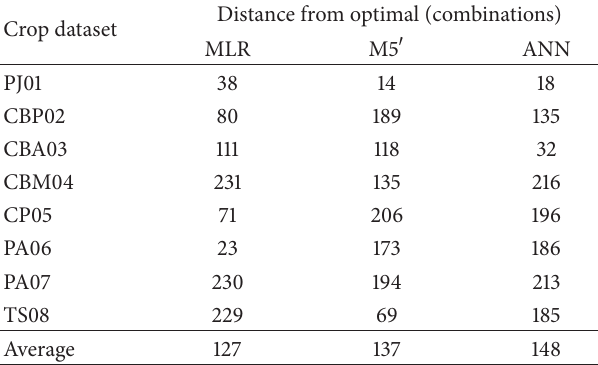
Table 7: Distance from OAS error measures using the potential attribute